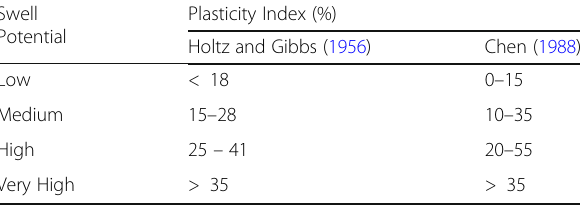
Table 3 Expansive soil classification based on plasticity index